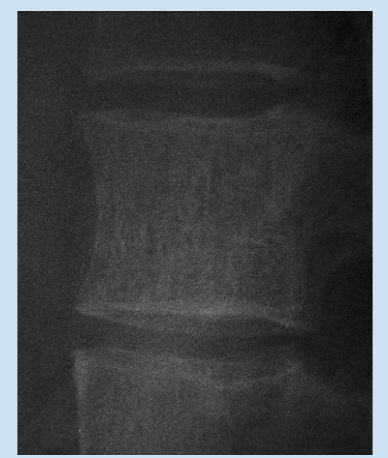
Fig.1a. In case 1 lateral thoracic radiograph demonstrates typical vertical sclerotic striated pattern of a haemangioma.